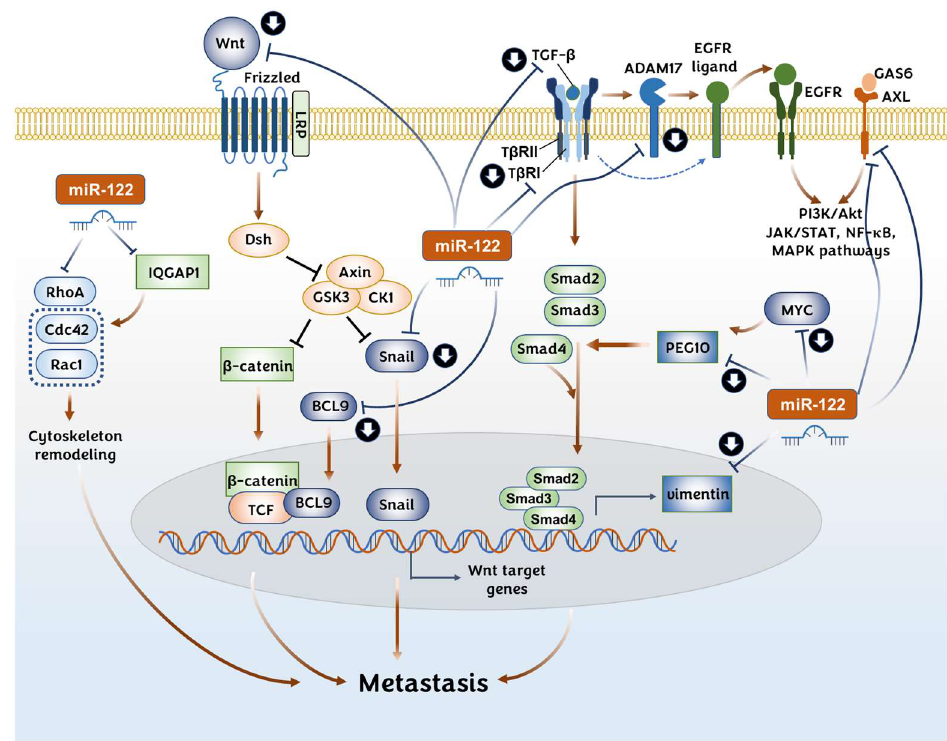
Figure 4. Regulation of metastasis of cancer cells by miR-122. Without any external stimulation, β-catenin is phosphorylated by the degradation complex kinases, comprising glycogen synthase kinase 3 (GSK3) and casein kinase 1α (CK1α). This leads to the degradation of β-catenin by the ubiquitin–proteasome pathway. The binding of the Wnt protein to the Frizzled receptor and co-receptors, such as the low-density lipoprotein receptor-related protein 5 (LRP5) or LRP6, initiates the dissociation of the degradation complex kinases, thereby stabilizing β-catenin and leading to the expression of Wnt target genes. miR-122 can downregulate the expression of WNT, BCL9, and vimentin, leading to the loss of their metastatic ability. The TGF-β signaling suppresses apoptosis and promotes EMT at the later stages of hepatocellular carcinoma (HCC) development. The activation of TGF-β transduces a signal through Smad proteins. Also, PEG10 regulates TGF-β signaling positively in HCC. miR-122 downregulates the expression of TGF-β, TβRI, and PEG10. TGF-β signaling can also enhance the EGFR signaling by activating ADAM17. Signaling by the AXL receptor, another target of miR-122, also contributes to the metastasis of HCC by activating PI3k/Akt, JAK/STAT, NF-κB, and MAPK pathways.